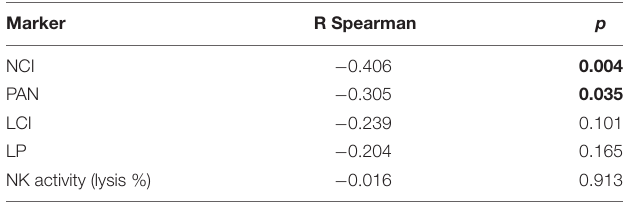
TABLE 6 | Correlation between immune markers and